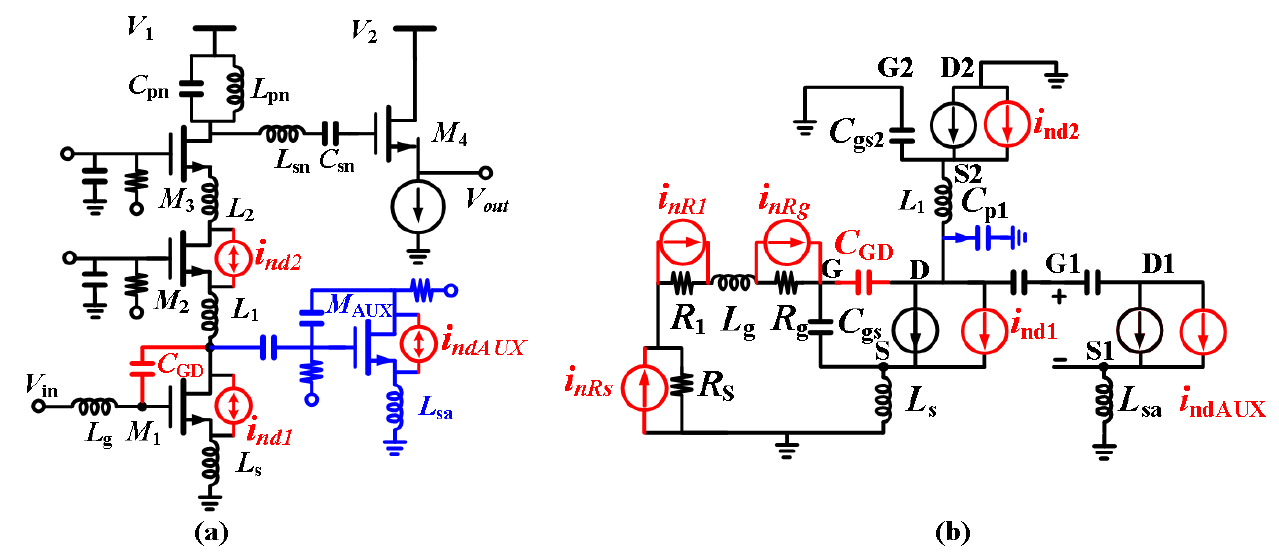
Figure 4. ( a ) Noise model for the inductively degenerated triple-cascode LNA; ( b ) equivalent circuit model for the calculation of noise performance.